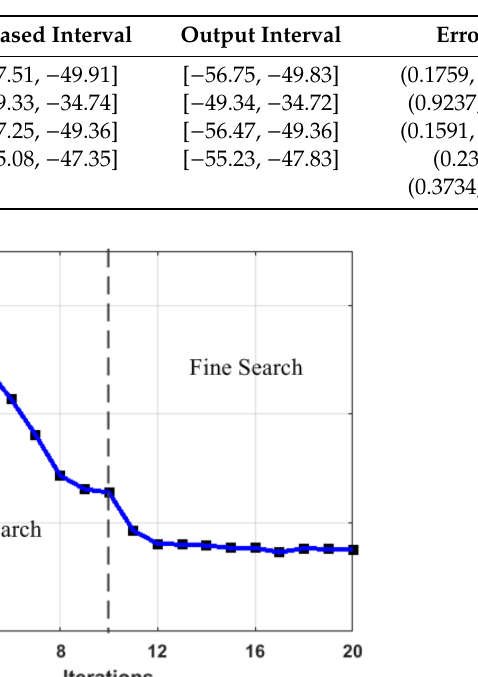
Table 2. Temperature intervals of the box heat transfer system.